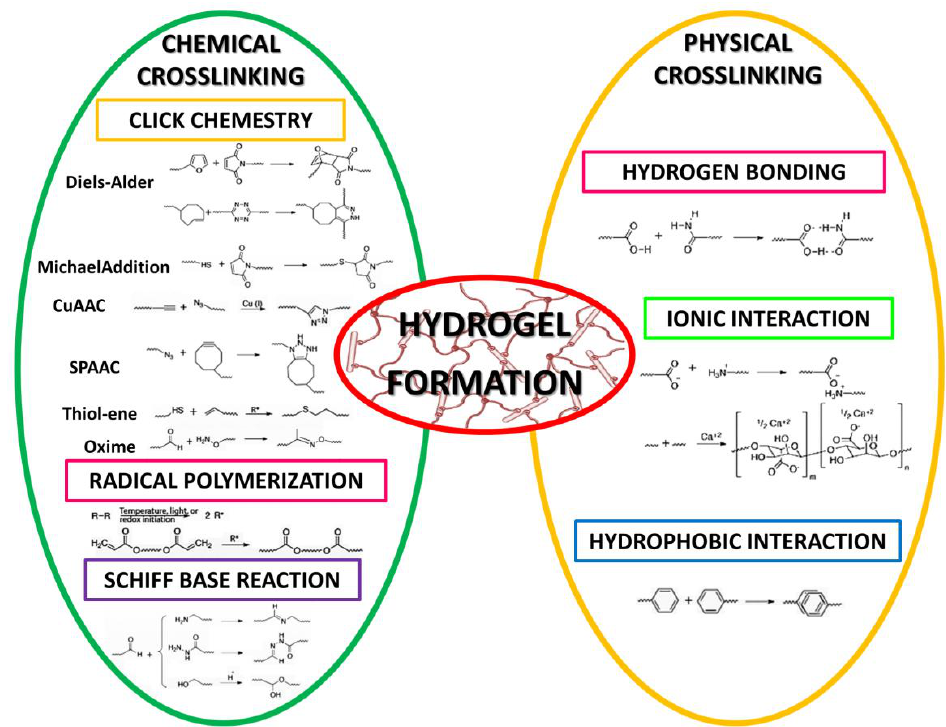
Figure 3. Chemical and physical crosslinking methods used to form hydrogels.